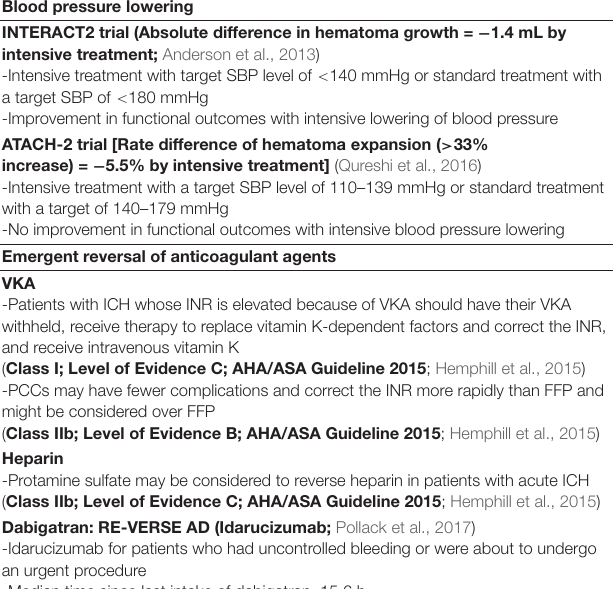
TABLE 1 | Current status of potential strategy for preventing hematoma expansion in patients with acute intracerebral hemorrhage (ICH). Blood pressure lowering INTERACT2 trial (Absolute difference in hematoma growth = − 1.4 mL by intensive treatment; Anderson et al., 2013) -Intensive treatment with target SBP level of < 140 mmHg or standard treatment with a target SBP of < 180